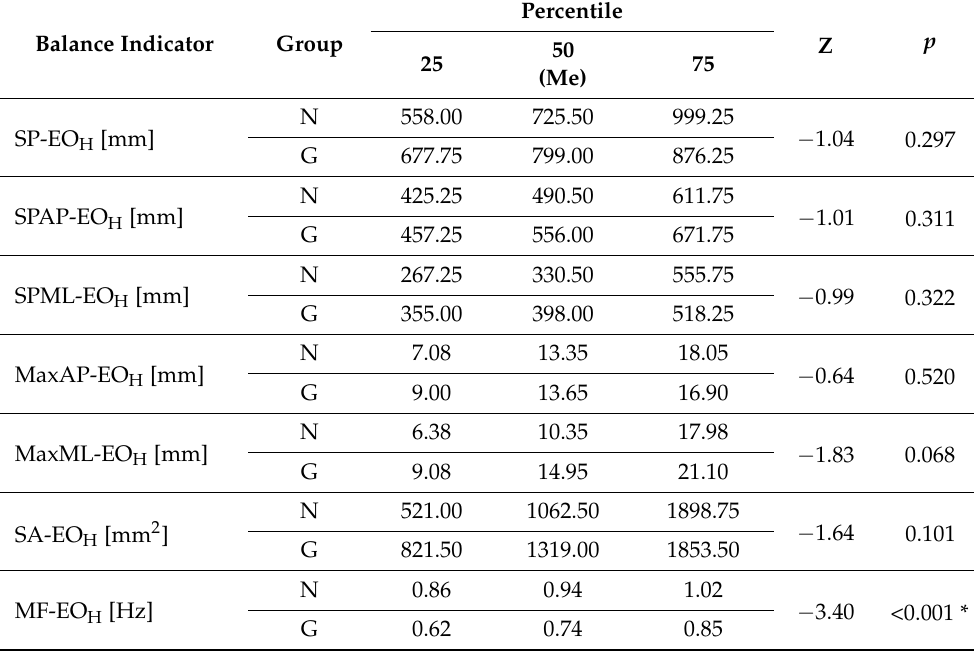
Table 4. Comparison of balance indicator values in tandem stance position with opened eyes and high (EO H ) between gymnasts and non-training